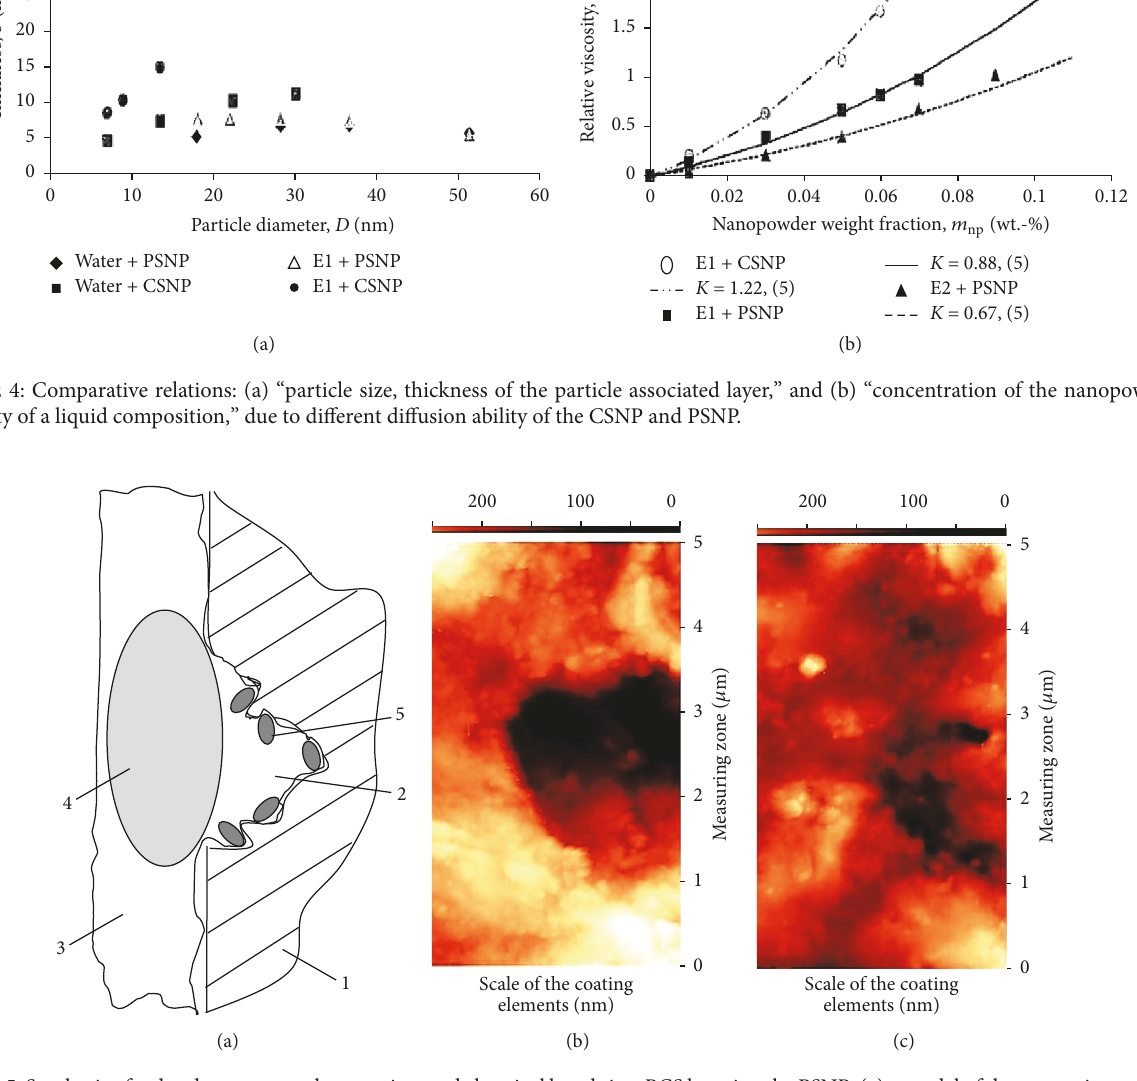
Figure 5: Synthesis of redundant structural constraints and chemical bonds in a PCS by using the PSNP: ( 1 ) a model of the constraints, where 1–5 are the painted surface, microcrack, coating layer, paint microparticle, and nanoparticle agglomerates of the modifiers; (b)-( c ) AFM of the bonds before and after the